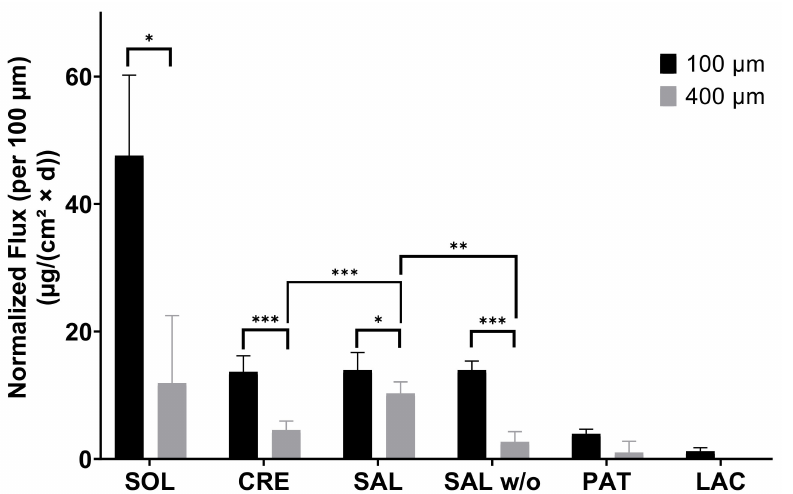
Figure 6. Respective fluxes of bifonazole through 100- µ m and 400- µ m healthy bovine hoof sheets (mean ± SD). Significance levels: * p < 0.05; ** p < 0.01; *** p < 0.001.